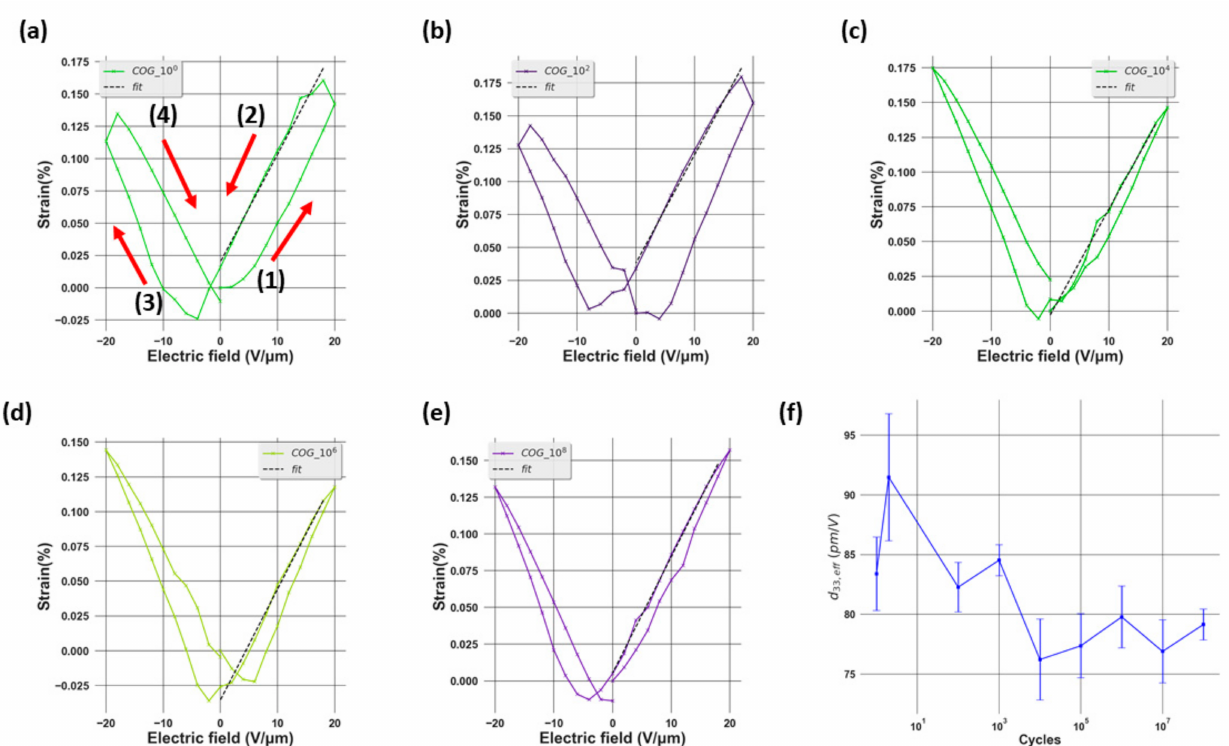
Figure 5. ( a – e ) The S–E curve at different numbers of electric field cycles with the first-order fitting for d 33 calculation and ( f ) the variation of d 33, eff as a function of the number of electric field